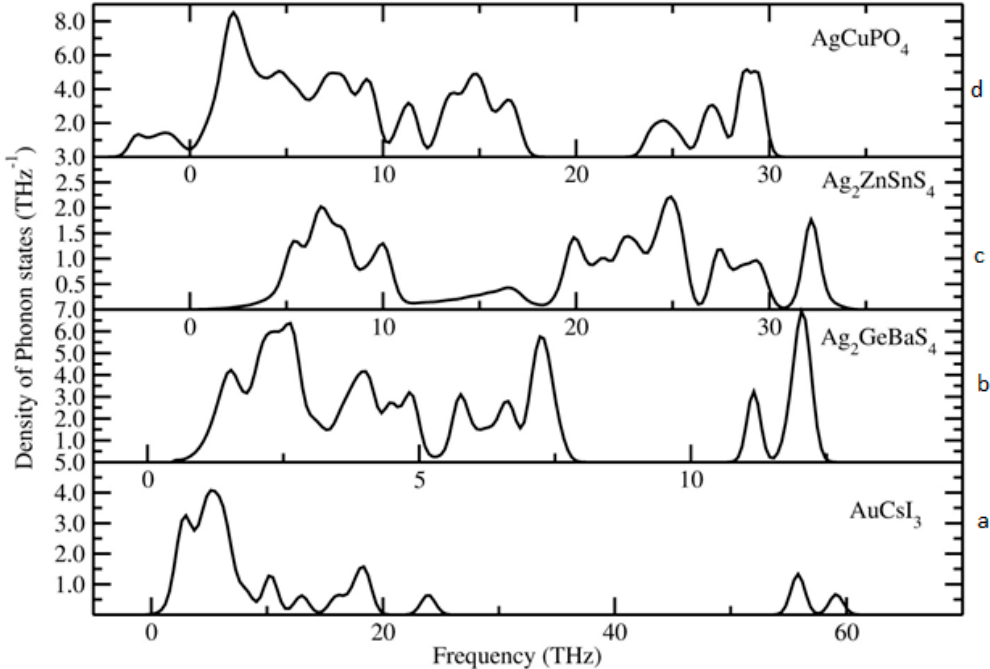
Figure 4. Calculated total phonon density of states for ( a ) Au 2 Cs 2 I 6 , ( b ) Ag 2 ZnSnS 4 , ( c ) Ag 2 GeBaS 4 , and ( d ) AgCuPO 4 phases.